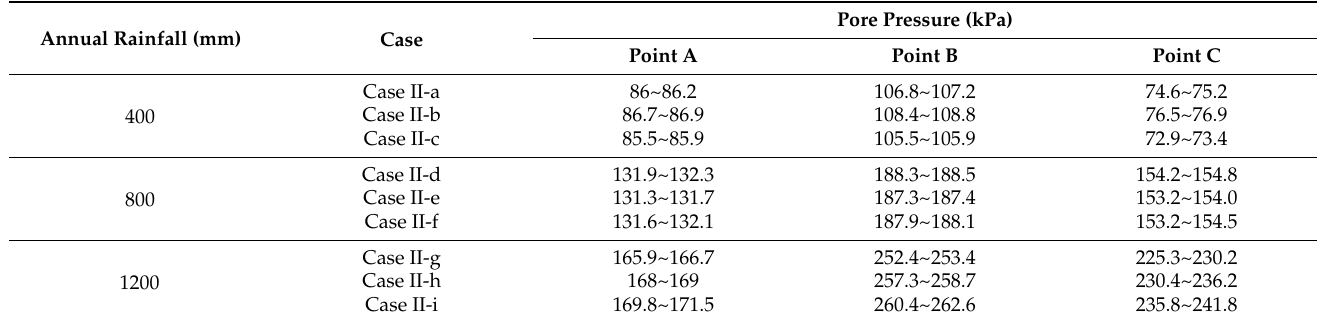
Table 4. Pore pressure variation range at each point in 50–150 years